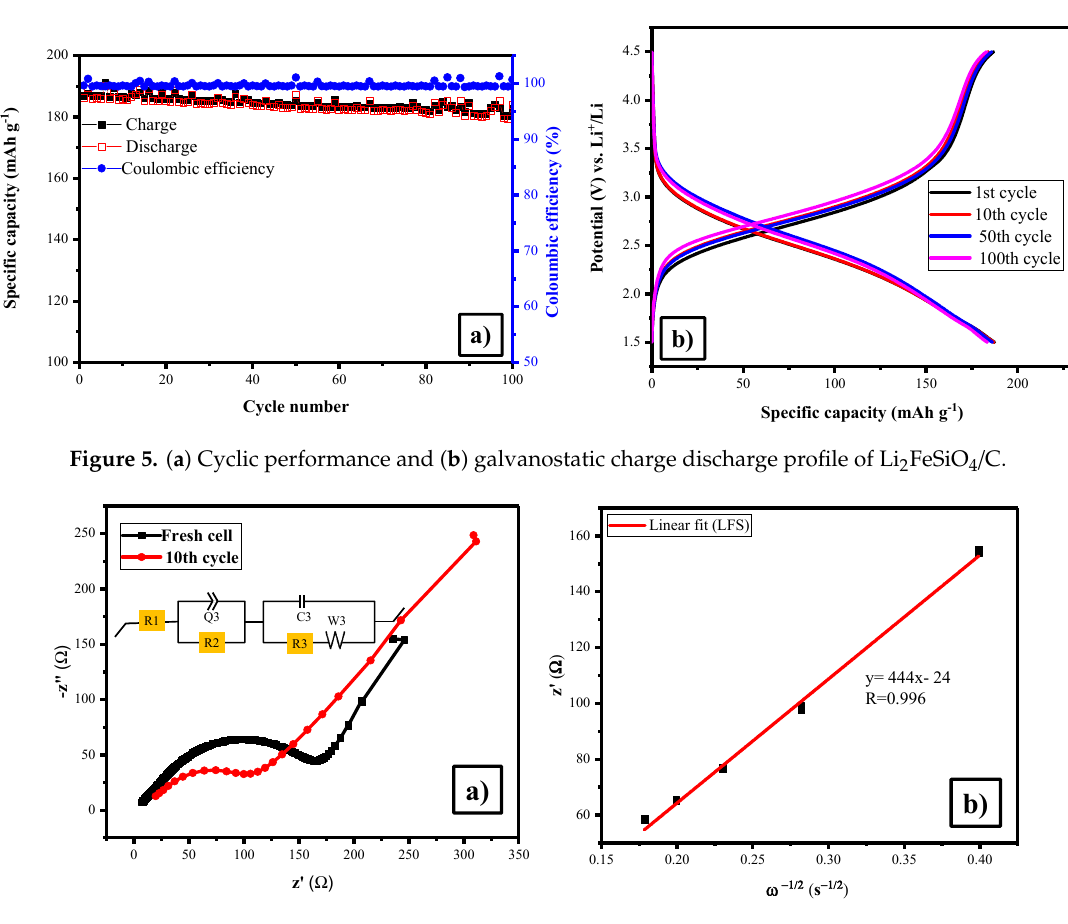
Figure 6. ( a ) Electrochemical impedance spectrum of Li 2 FeSiO 4 / C at fresh and 10th cycle ( b ) lithium di ff usion coe ffi cient for LFS.